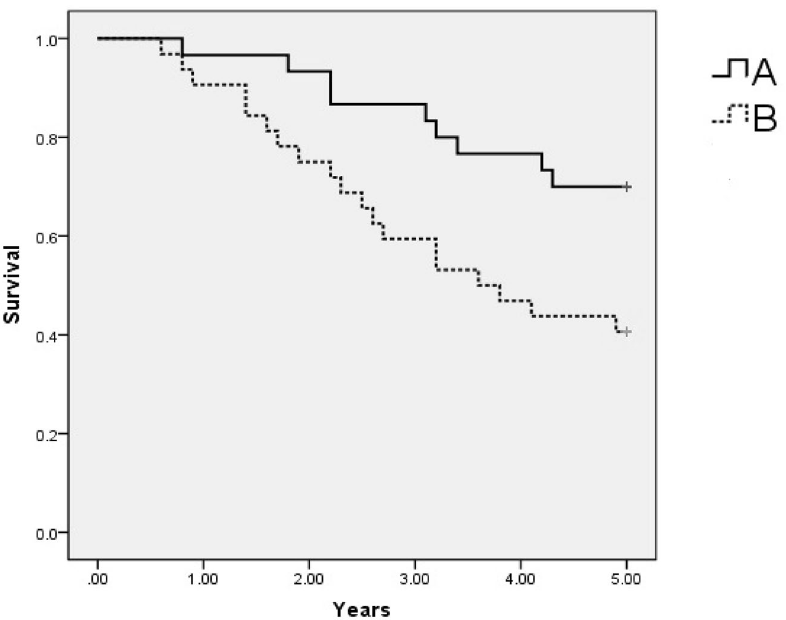
Figure 3. Kaplan–Meier curve shows overall survival rates for patients who received 125 I implantation ( A ) and for those who underwent radiochemotherapy ( B